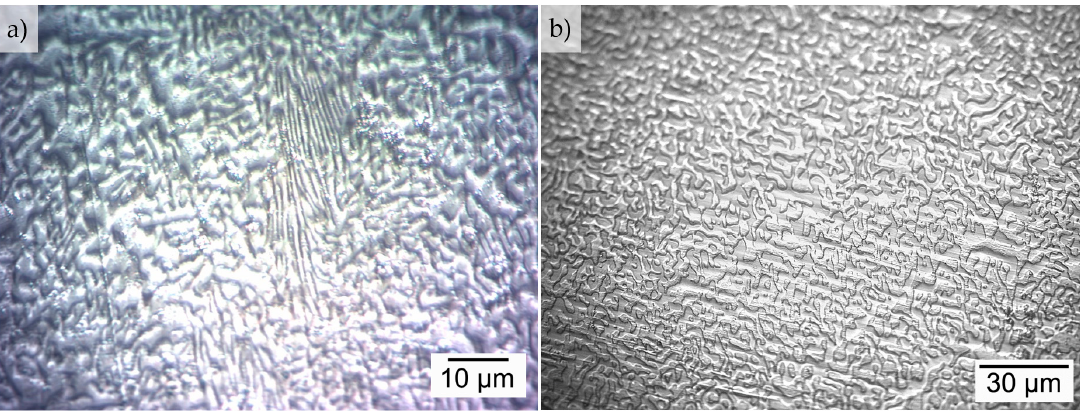
Figure 5. Optical micrograph of eutectic Al-Cu directionally solidified after annealing for: ( a ) 4 h and, ( b ) 24 h.